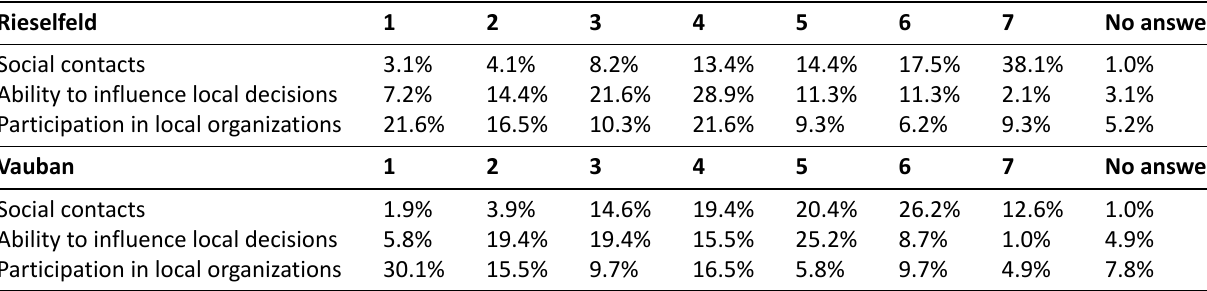
Table 7. Level of social engagement in